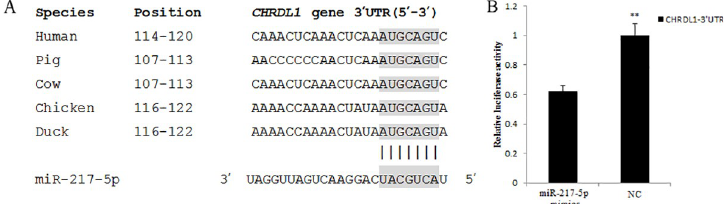
Fig 6. Validation of a select miRNA and a select target gene by qRT-PCR. (A) Binding sites for miR-217-5p in the CHRDL1 3’UTR of different species. (B) Luciferase activity assay of the recombined dual-luciferase reporter vectors with the 3’UTR of CHRDL1 co-transfected with miR-217-5p mimics or NC. �� indicates P < 0.01.